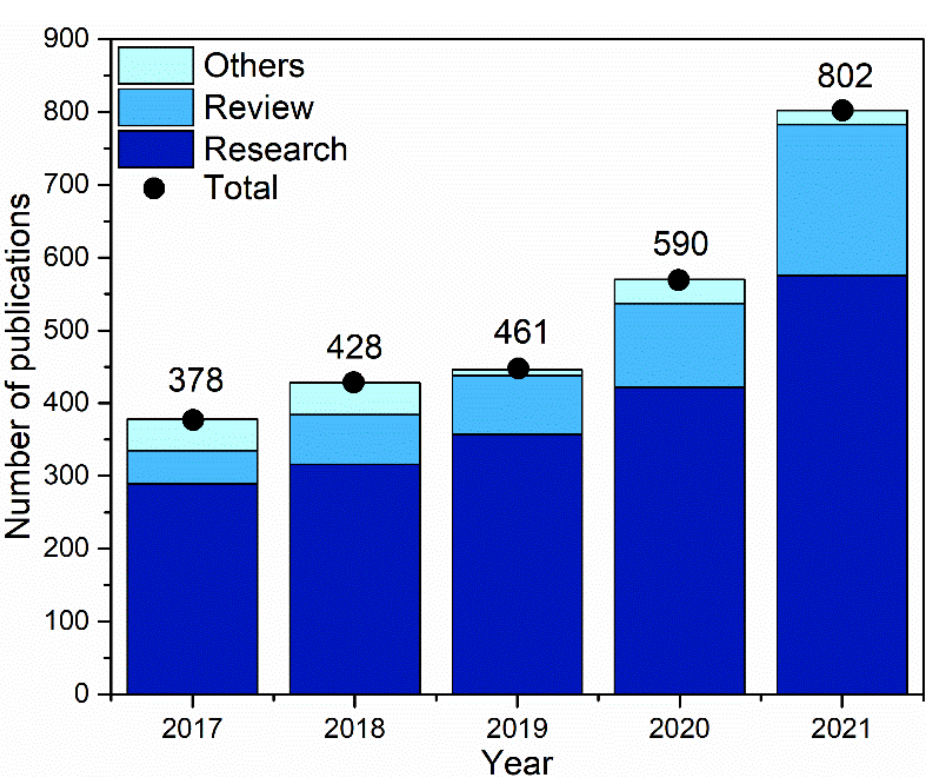
Figure 3. Number of articles per year containing the word ‘electroplating ionic liquid solution’ in